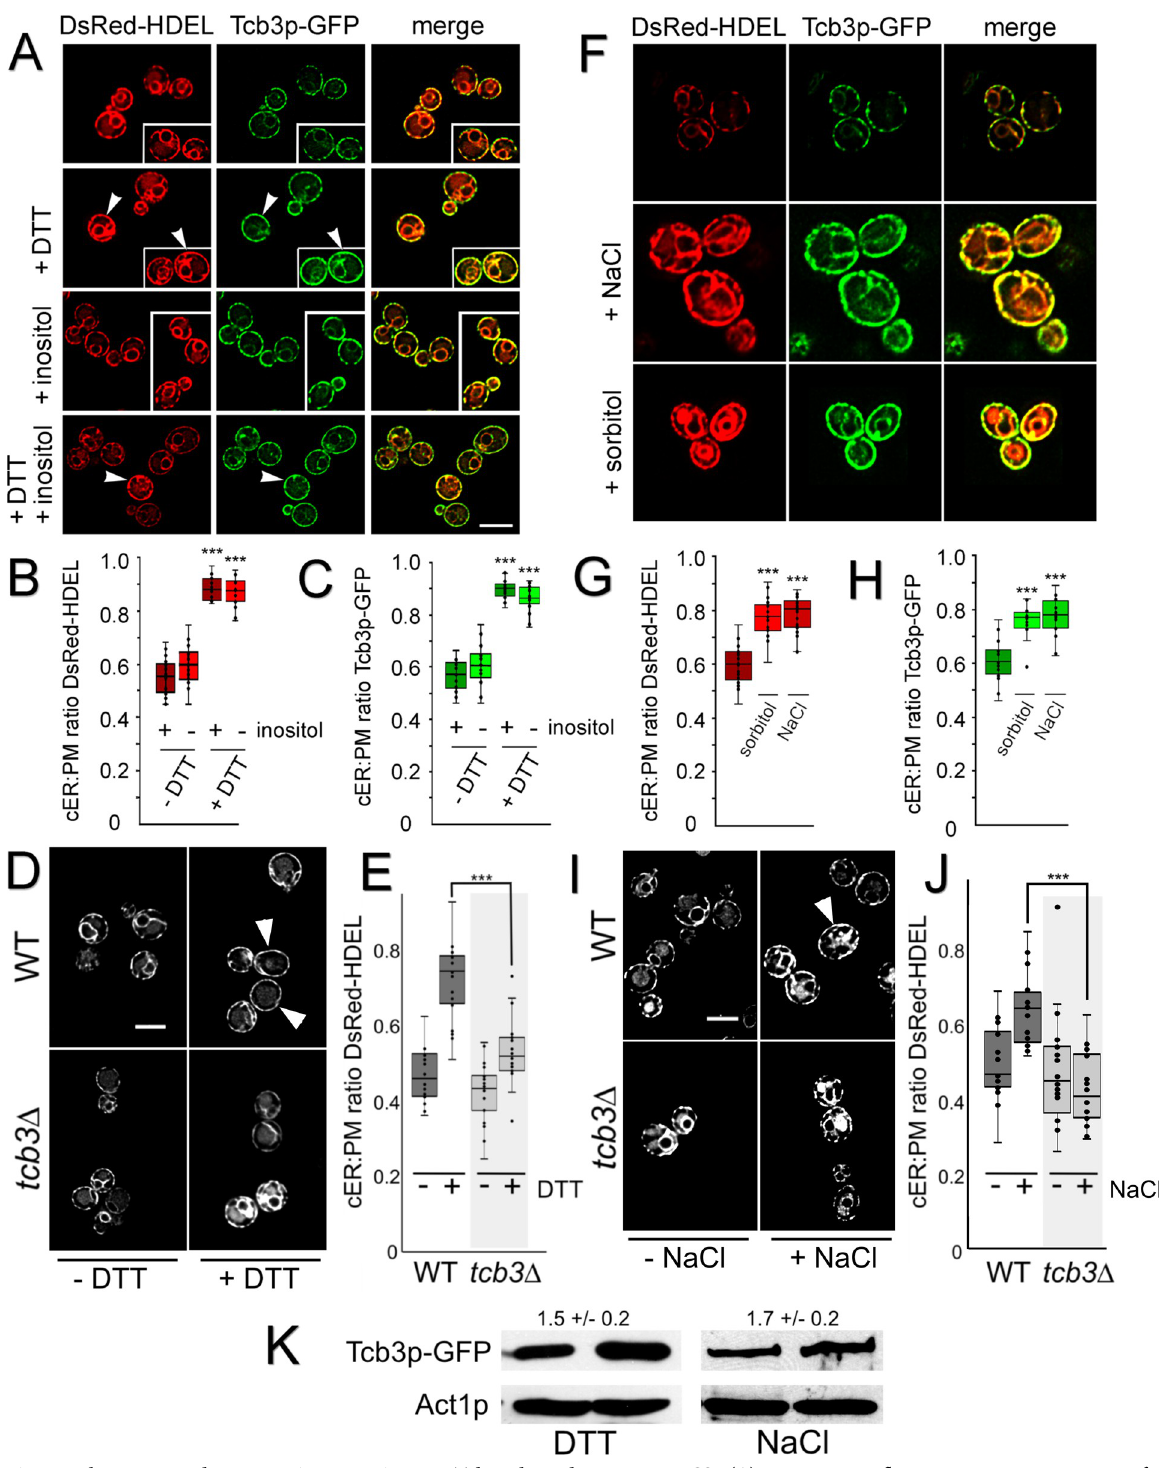
Fig 9. Both ER UPR and PM osmotic stresses increase Tcb3p-dependent ER-PM MCSs. (A) Representative fluorescent microscopy images of WT cells (CBY6087) expressing DsRed-HDEL (pRS416-DsRed-HDEL) and TCB3 -GFP. Cells grown in synthetic minimal media with or without 75 μ M inositol were treated with 2 mM DTT at 30˚C for 2 h. ( B) Ratios of the total length of cortical DsRed-HDEL fluorescence (cER) per total PM in WT, and ( C) Relative ratios of cortical Tcb3p-GFP fluorescence per PM in WT cells, corresponding to A (n = 20 cells per condition). ( D ) Representative images of WT (BY4742) and tcb3 Δ (CBY7354) cells expressing DsRed-HDEL treated with 2 mM DTT at 30˚C for 2 h. ( E )